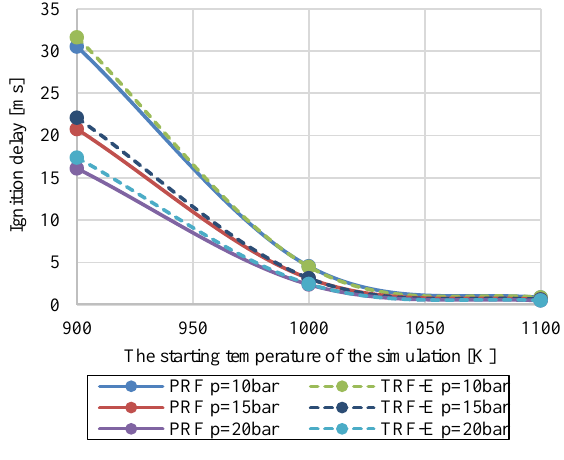
Fig. 19. Ignition delay for PRF and TRF-E